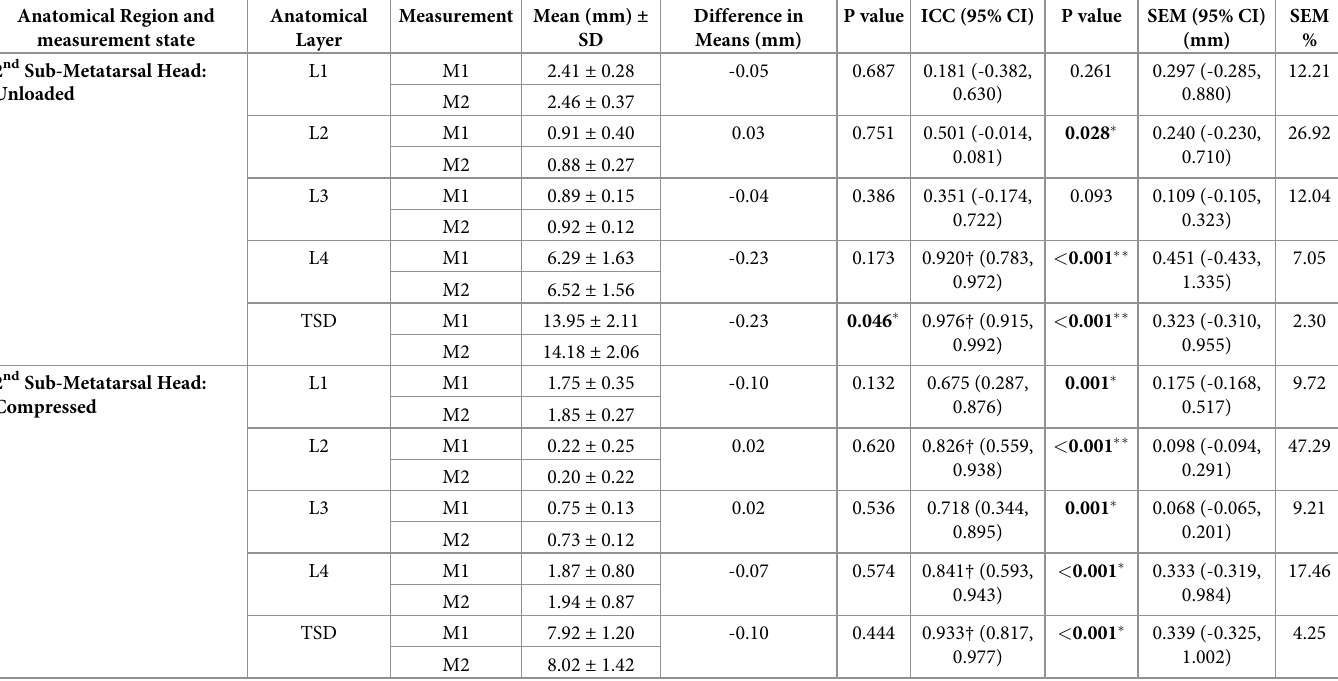
Table 4. Results for intra-observer reliability testing of skin and fat pad thickness at the 2 nd sub-metatarsal head foot region. Anatomical Region and measurement